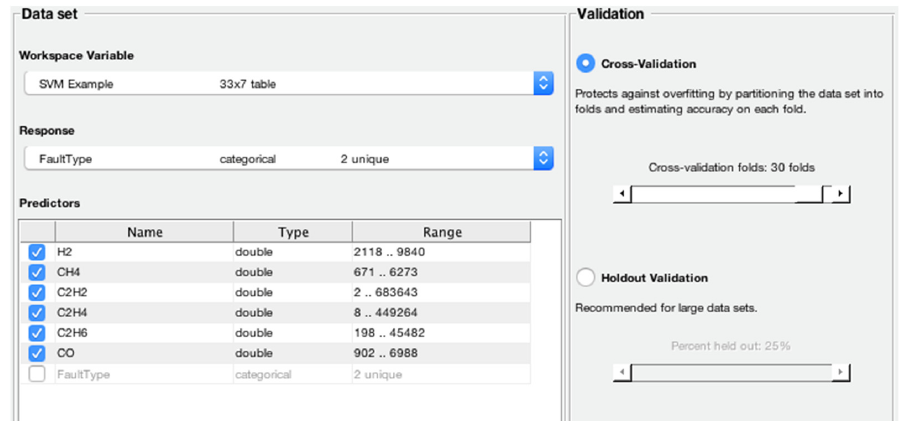
Figure 8. The dataset variables selected by the SVM 2 classifier.